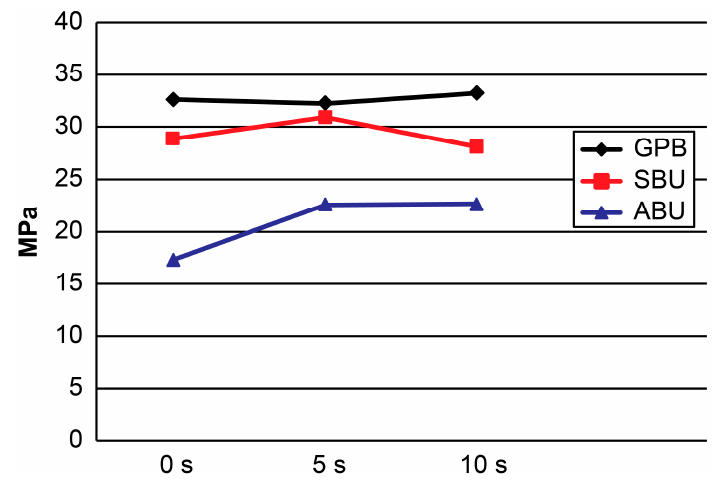
Figure 2. μ TBS means obtained in self-etch mode. GPB: G-Premio Bond; SBU: Single Bond Universal; ABU: All Bond Universal.